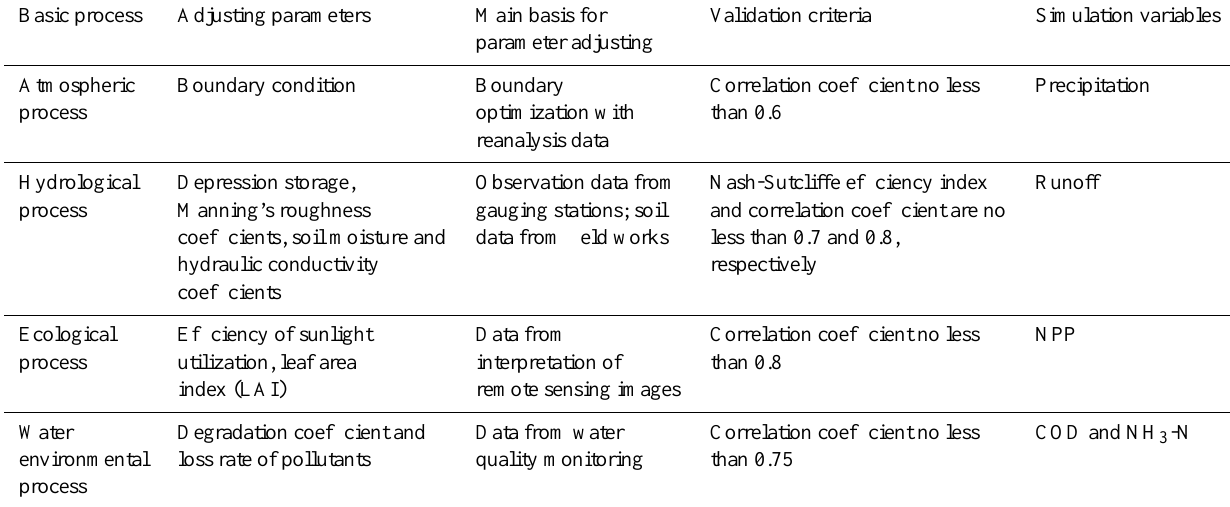
Table 3. Information for parameter